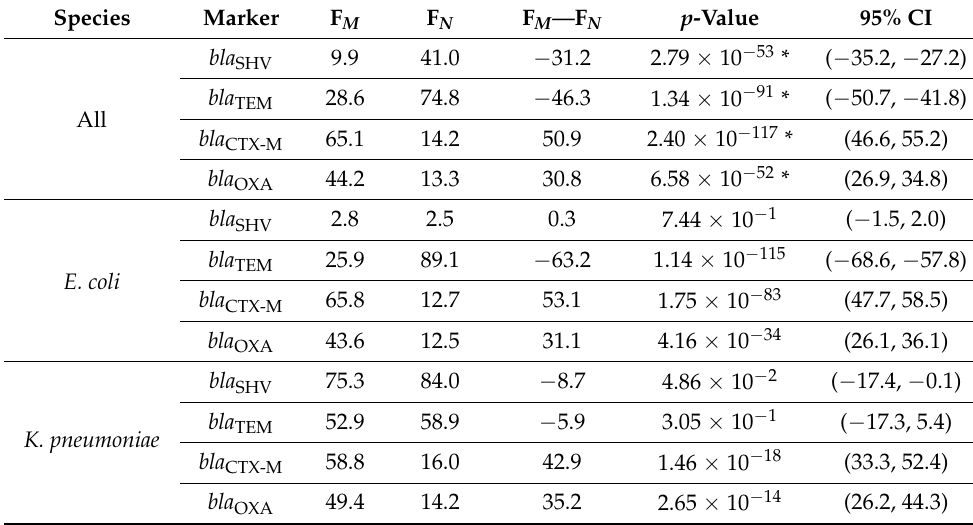
Table 5. Percent frequency differences between resistance markers at DHMMC and the Nationwide Database. The frequency of a resistance marker from DHMMC is denoted F M , and the frequency of a resistance marker from the National Database is denoted by F N . An asterisk (*) indicates a statistically significant comparison after the FDR-controlling procedure ( q * = 0.025). The last column provides the 95% confidence interval for the percent difference for a particular resistance marker between the two datasets.